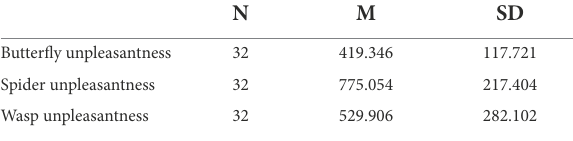
TABLE 1 Descriptive statistics of the unpleasantness results.